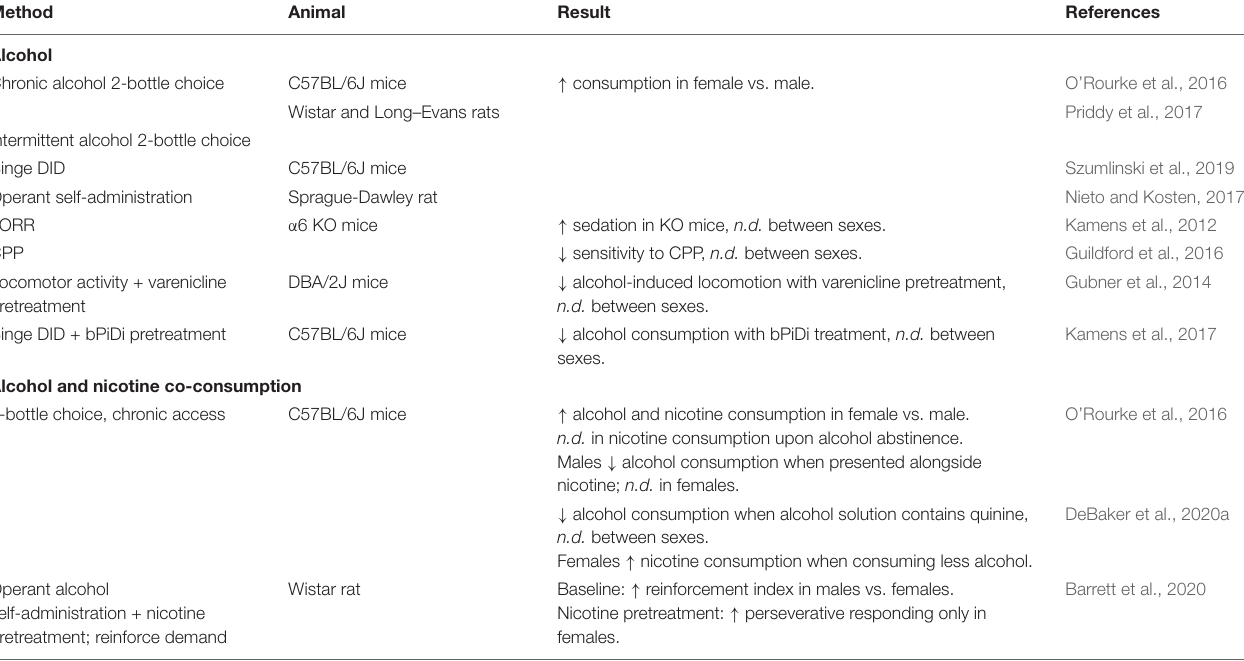
TABLE 4 | Summary of sex differences in highlighted alcohol behavioral